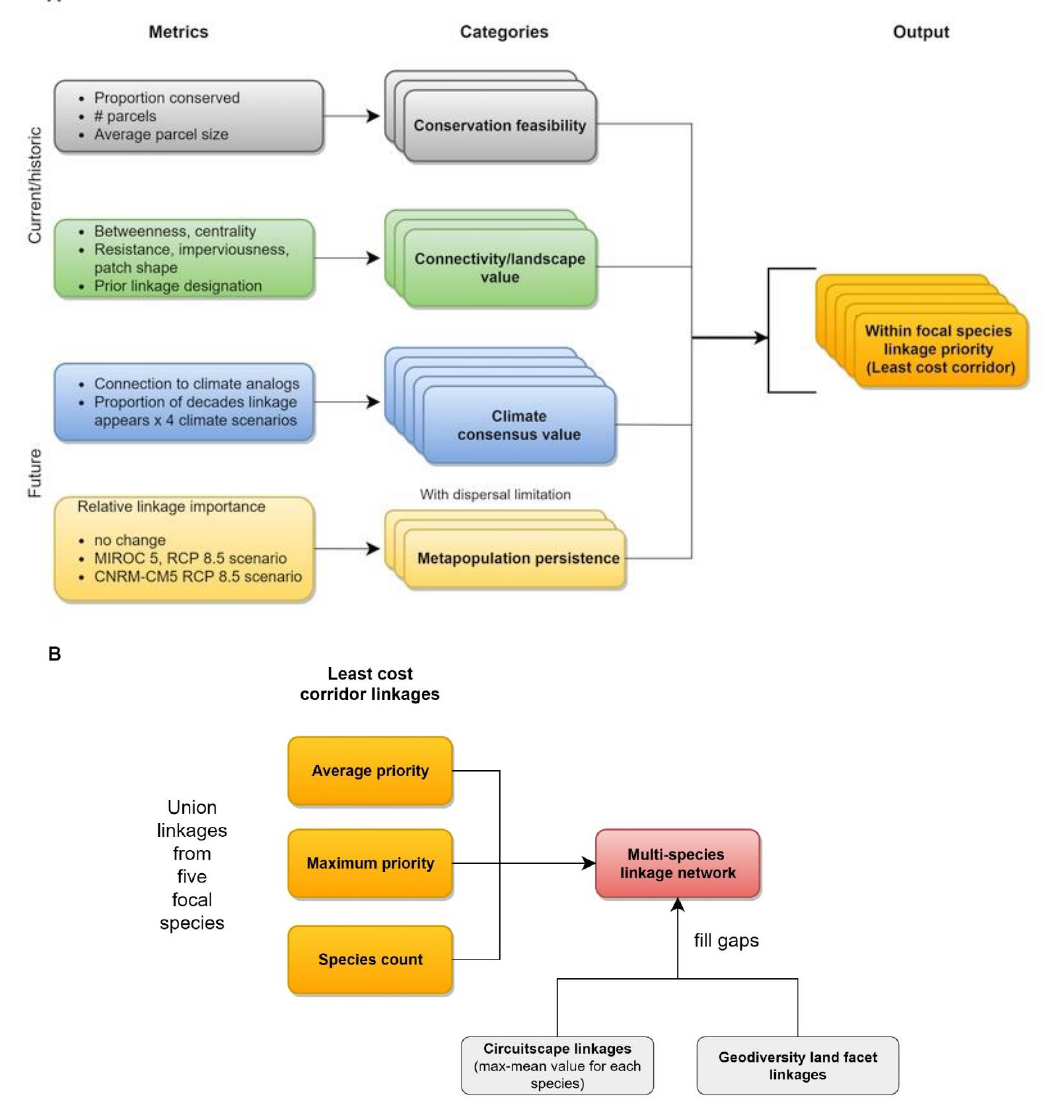
Figure 3. Conceptual model of how individual focal species linkages are assembled into a single multispecies network. ( A ) Depicts the within-species prioritization of least cost corridor linkages for each focal species. Prioritization was based on metrics that were grouped into four categories, conservation feasibility, connectivity and landscape value, climate consensus, and metapopulation persistence. ( B ) Illustrates how the multispecies linkage network was assembled from the union of the within-species prioritization values with linkages from the Circuitscape and land facet analyses used to fill gaps in the network.